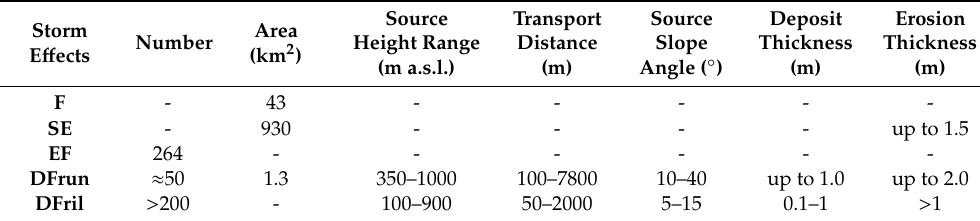
Figure 7. Inventory map of the hydrogeological effects of the storms on 14–15 and 19–20 October 2015 in the Benevento province. Table 2. Main morphometric features of the flooding and hillslope processes. F, Floods; SE, Soil Erosion; EF, Earth Flow; D, Frun; Debris Flows generated by concentrated runo ff ; D, Fril; Debris Flows initiated by